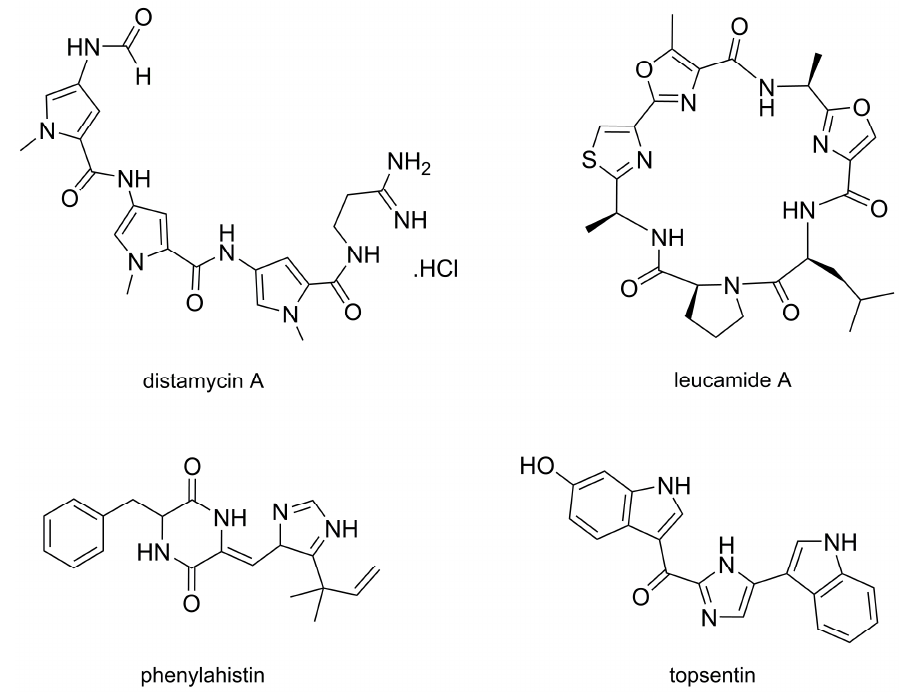
Figure 1. Structures of distamycin A, leucamide A, phenylahistin, and topsentin, four examples of natural antitumor compounds exhibiting a variety of pentameric heterocycles.